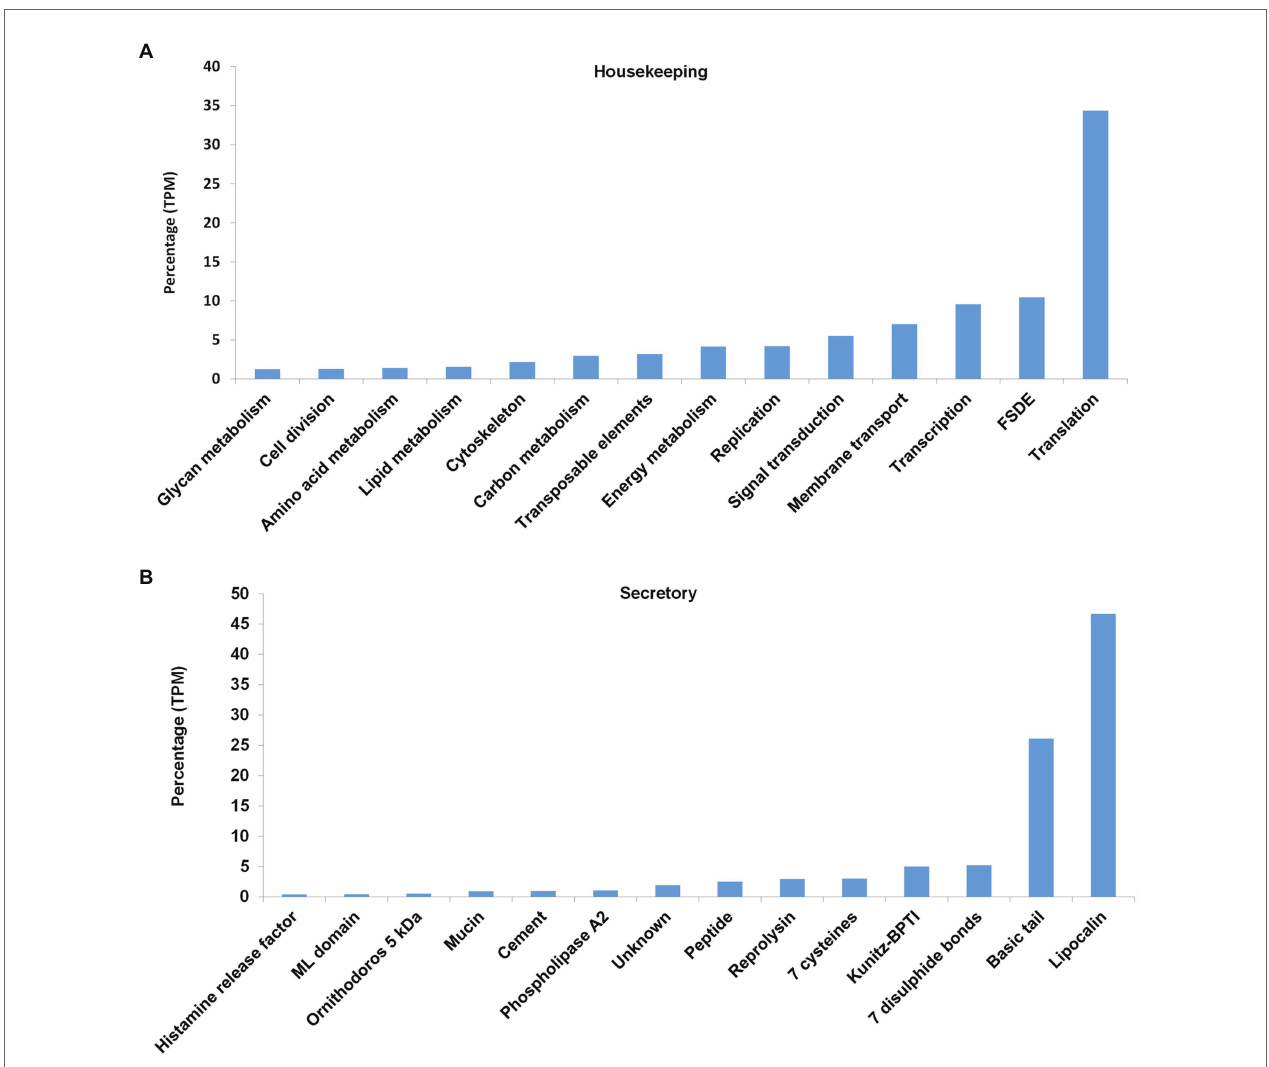
FIGURE 6 | Abundance of housekeeping and secretory proteins expressed as percentage of total coverage (TPM). (A) For the housekeeping proteins, the classes with >1% total coverage (~90% of total coverage) are indicated. FSDE: folding, sorting, degradation, and excretion. (B) For the secretory proteins, the classes with >0.2% total coverage (~98% of total coverage) are